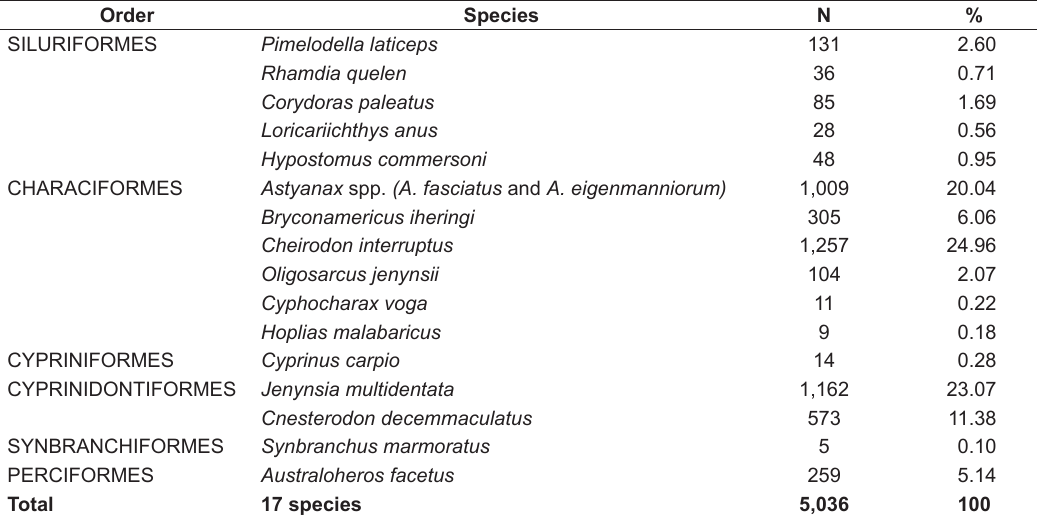
Table 1. List of the species collected at the Del Azul stream during the period of the study. Number of individuals of each species (N) and relative abundance (%). All species are native except for Cyprinus carpio. Order